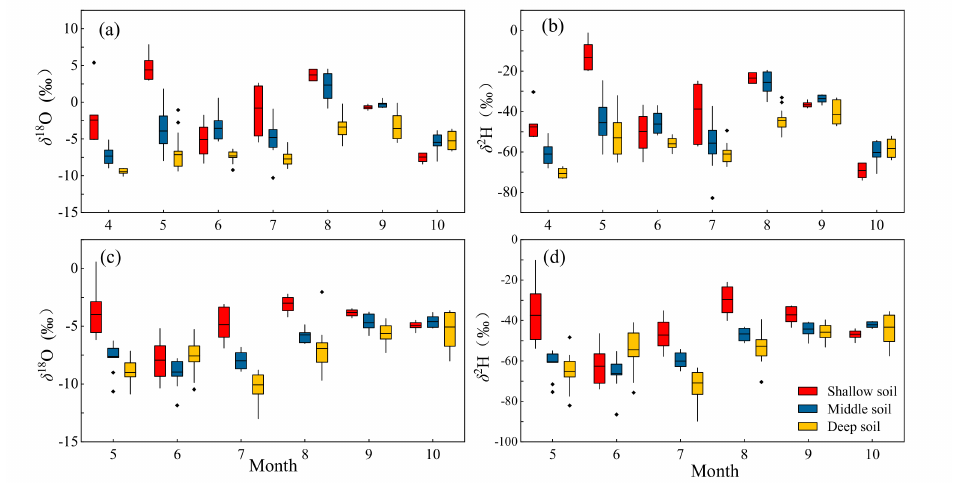
Figure 5. Isotopic composition of three soil layers water in hillside ( a , b ) and floodplain ( c , d ) for each sampling campaign, where (a,c) are the values of δ 18 O, (b,d) are the values of δ 2